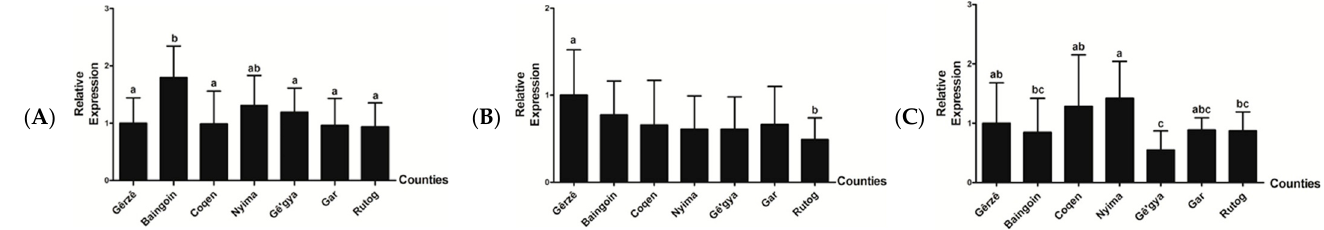
Figure 5. Relative mRNA expression of genes IGF-1 ( A ), FGF5 ( B ), and KAP 1.4 ( C ) in ear skin tissue of the Northwestern Tibetan cashmere goat among seven counties. Data are mean ± SD from three independent experiments. Different letters stand for significant difference ( p < 0.05).